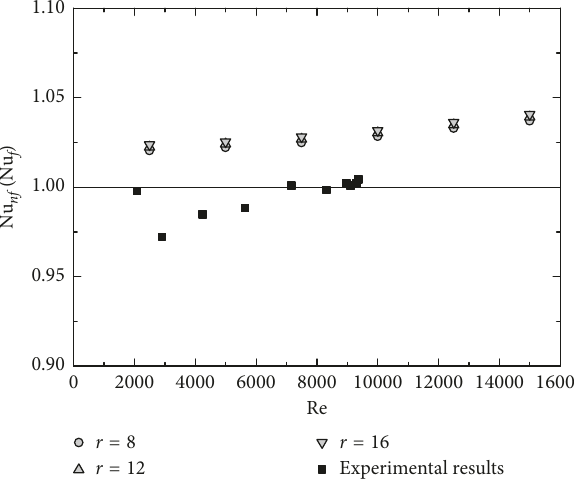
Figure 8: Nu nf /Nu f as a function of the Reynolds number by different aspect ratios ( ϕ 0.93%). (cid:31)